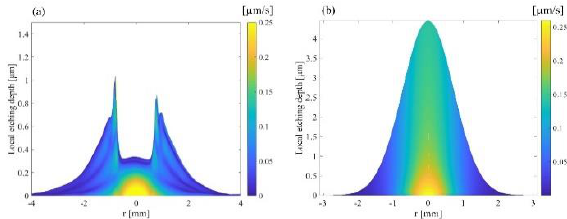
Fig. 2. Radial etch rate distribution functions on N-BK7 obtained from static footprint etching depending on layer thickness at different surface temperatures: (a) T S =25°C, (b) T S =350°C.